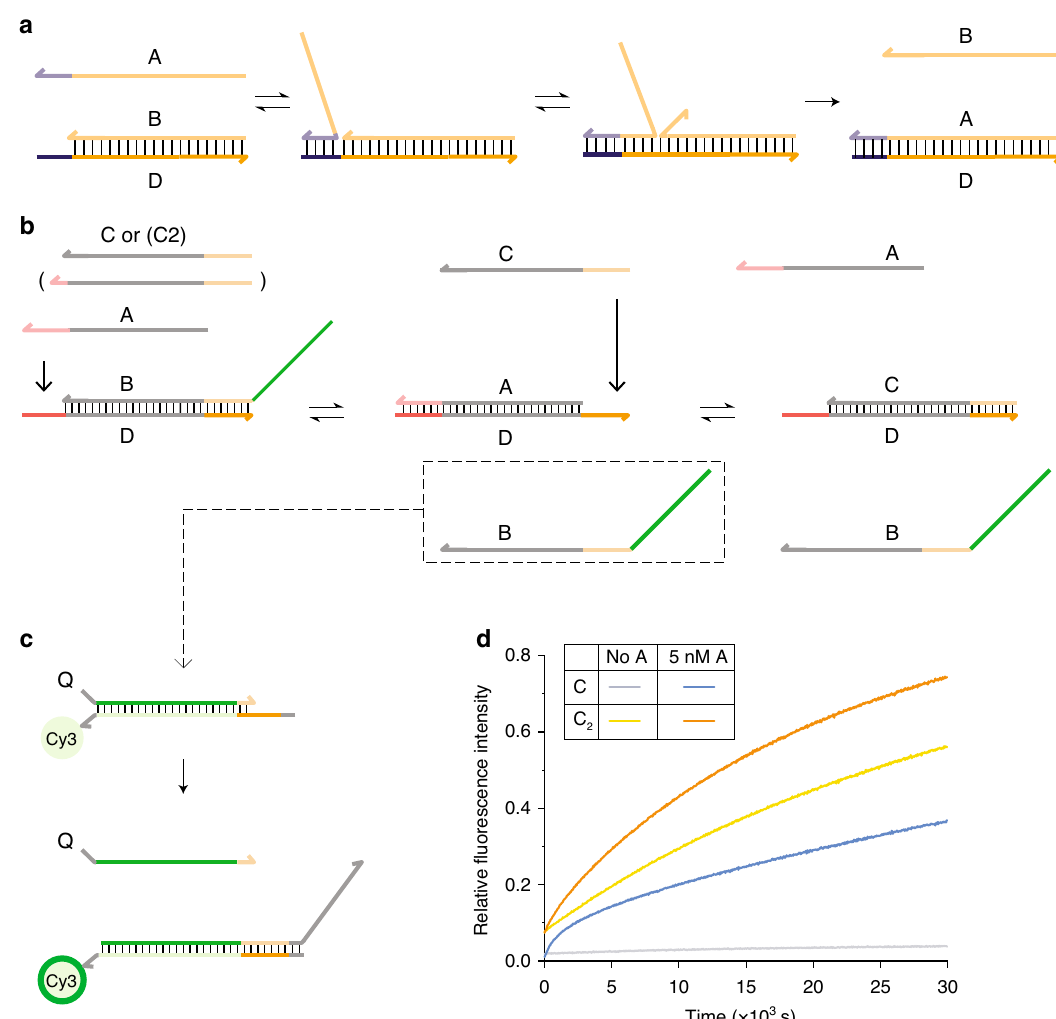
Fig. 1 Strand displacement and catalysis in DNA nanotechnology. a Toehold-mediated strand displacement. The reactant duplex BD can be attacked by an invading strand A that is complementary to the whole of D , including an initially single-stranded toehold. b A simple catalytic motif engineered through toehold exchange. Displacement of B by A (which are complementary to different but overlapping domains of D ) exposes a second toehold that allows the subsequent displacement of A by C . A can thus act as a catalyst for the interconversion of BD and CD , providing control over the reaction. c Addition of a fl uorescent reporter for single-stranded B allows the progress of the reaction to be monitored. d Normalised fl uorescence data showing the effect of adding catalyst A on the catalytic scheme in b with 22 bp duplexes and 6 nt toeholds. A total of 40 nM of BD is mixed with 200 nM of C and 250 nM of reporter complex, both with and without triggering by addition of 5 nM of A . Output in the absence of A (the leak reaction) is low, but the reaction yield after 500 minutes is limited, a problem exacerbated by the similar stabilities of reactant and product. A longer strand C 2 that can form two extra base pairs with D (in the toehold domain for binding of A ) increases yield over 500 minutes but at the cost of a loss of catalytic control: the leak reaction in the absence of the catalyst is now extremely strong. Each curve represents a single experiment; a repeat is shown in Supplementary Fig. 7. A full list of sequences is provided in Supplementary Table